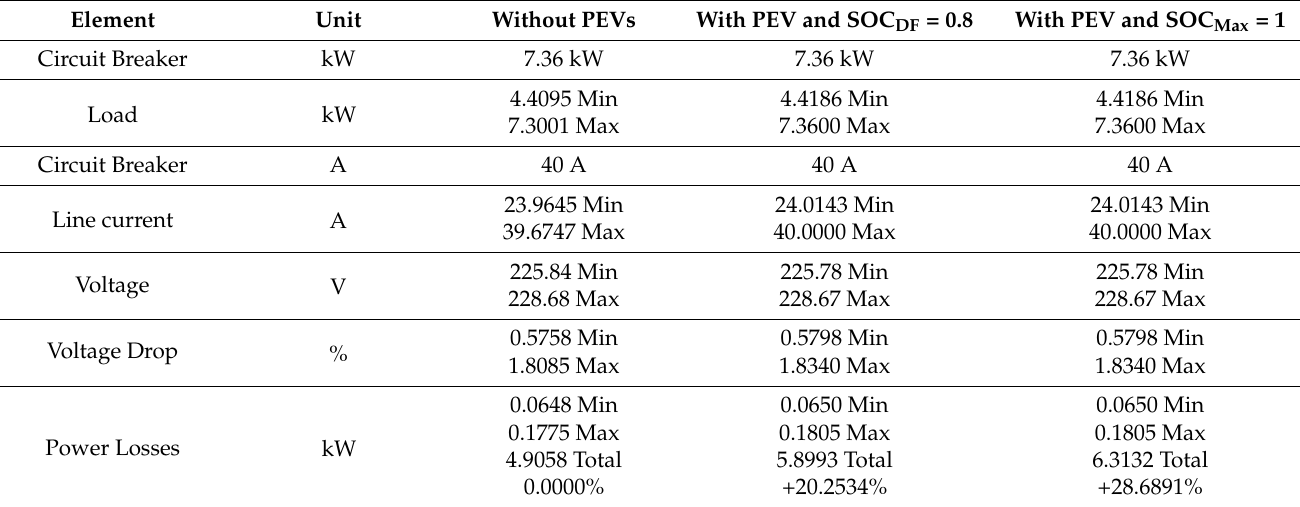
Table 2. Power demand and loss, current and voltage at home (time-of-use).